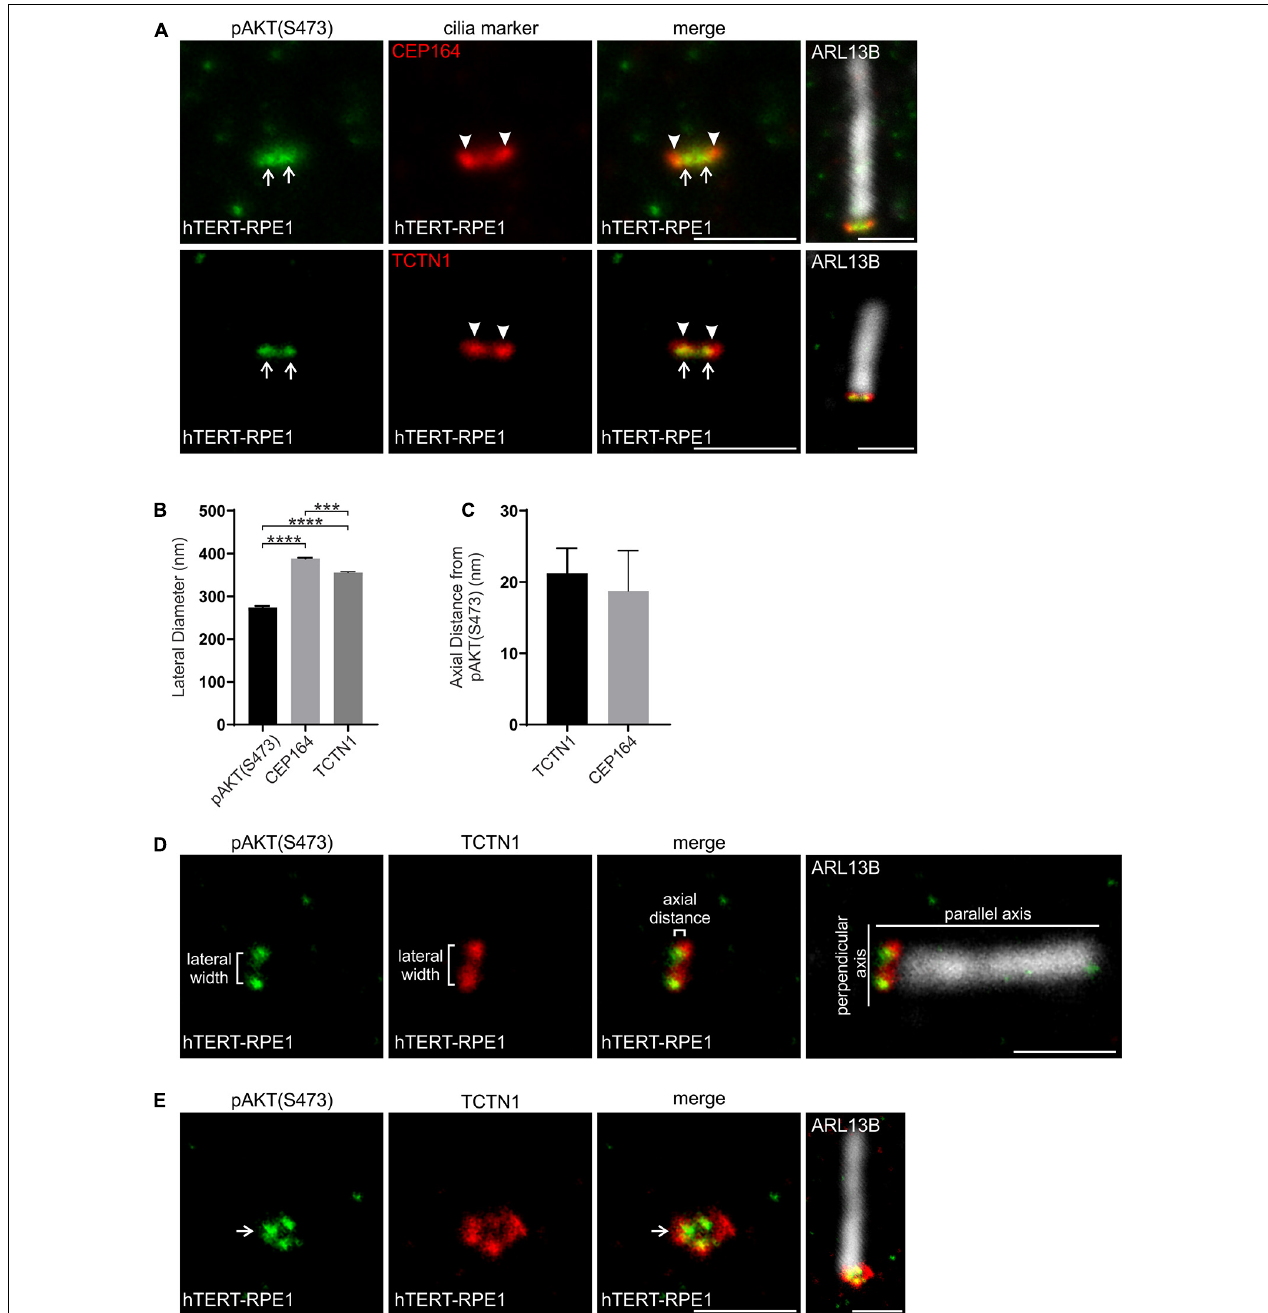
FIGURE 6 | pAKT(S473) localizes in close proximity to the PIs at the transition zone. (A) Ciliated hTERT-RPE1 cells were immunostained with pAKT(S473) (green), CEP164 or TCTN1 (red) and ARL13B (grayscale) antibodies and imaged by STED microscopy (confocal resolution image of the ARL13B stained axoneme is shown). Right panels show merged image at lower magnification. Arrows indicate transition zone pAKT(S473) signal, arrow heads indicate CEP164 or TCTN1, bar indicates 1 µ m. (B) Graph shows the lateral diameter between the highest intensity points of the pAKT(S473), CEP164 or TCTN1 puncta perpendicular to the plane of the axoneme. Bars represent mean ± SEM, n = 3 independent experiments, ≥ 30 cilia imaged per experiment and all cilia with two distinct pAKT(S473), CEP164 or TCTN1 puncta measured, statistical significance was determined using one-way ANOVA ( p < 0.0001) followed by Tukey’s post hoc test, *** p < 0.001, **** p < 0.0001. (C) Graph shows the axial distance between the highest intensity point of the pAKT(S473) signal and CEP164 or TCTN1 parallel to the plane of the axoneme. Bars represent mean ± SEM, n = 3 independent experiments, ≥ 30 cilia imaged per experiment and all cilia with distinct pAKT(S473), CEP164 or TCTN1 puncta measured, statistical significance was determined using Student’s t-test ( p = 0.7284). (D) Representative image showing the method used for the lateral diameter and axial distance measurements, bar indicates 1 µ m. (E) Ciliated hTERT-RPE1 cells were immunostained with pAKT(S473) (green), TCTN1 (red) and ARL13B (grayscale) antibodies and imaged by STED microscopy (confocal resolution image of the ARL13B stained axoneme is shown). Arrow indicates ring shaped transition zone pAKT(S473) morphology, bar indicates 1 µ m.